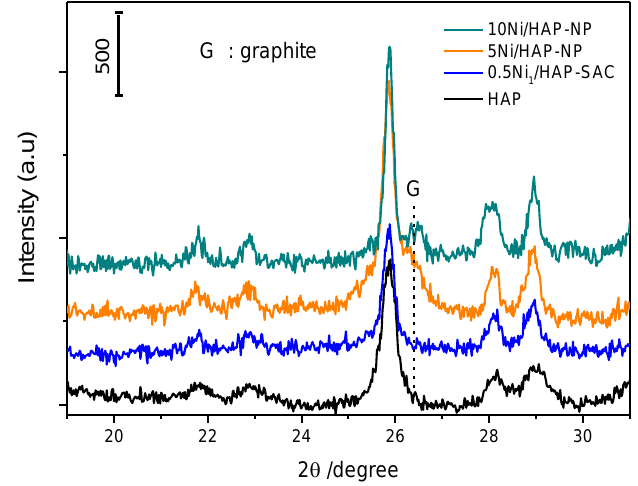
Figure 11. XRD patterns of the Ni/HAP catalyst after reaction at 750 °C.